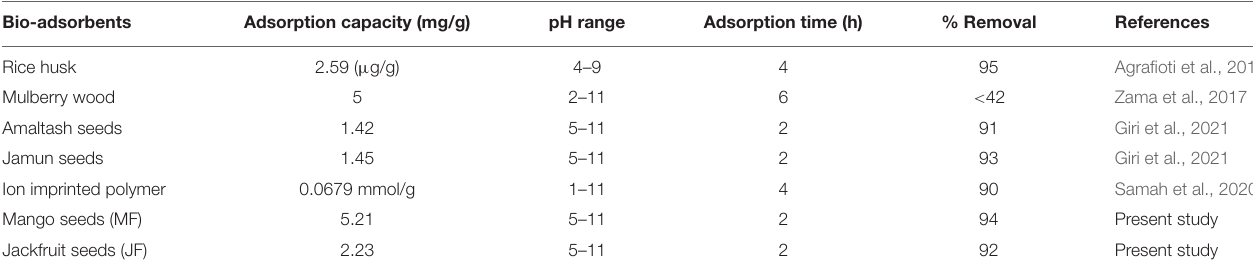
TABLE 4 | Comparison between present study and reported adsorbents materials for the adsorption of chromium ions.